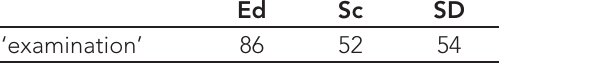
Table 3: Semantic focus of example of summative assessment task Ed Sc SD ‘examination’ 86 52 54